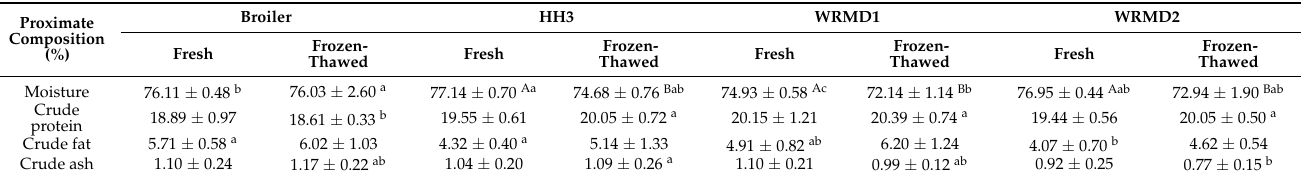
Table 1. Comparison of proximate composition of fresh and Frozen-Thawed chicken meats from Korean native chickens and